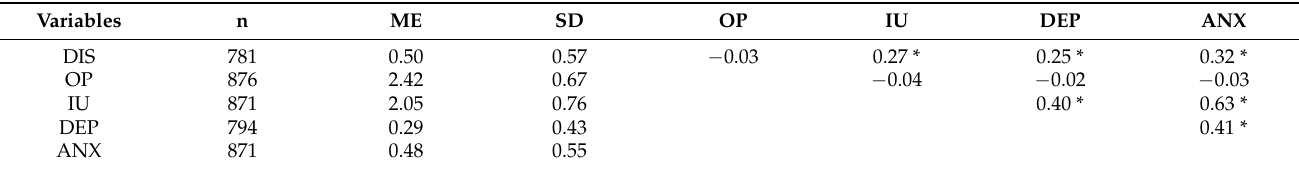
Table 2. Scores of the variables included in the model.